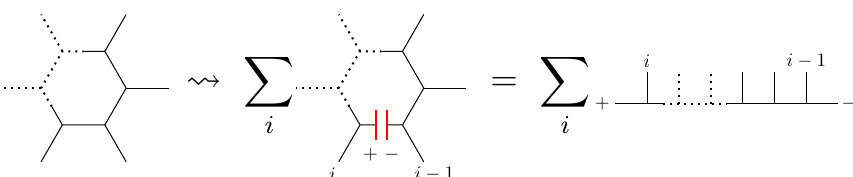
Figure 3 . Diagrammatic depiction: interpretation of the I representation of loop integrands as ( n + 2)-particle tree